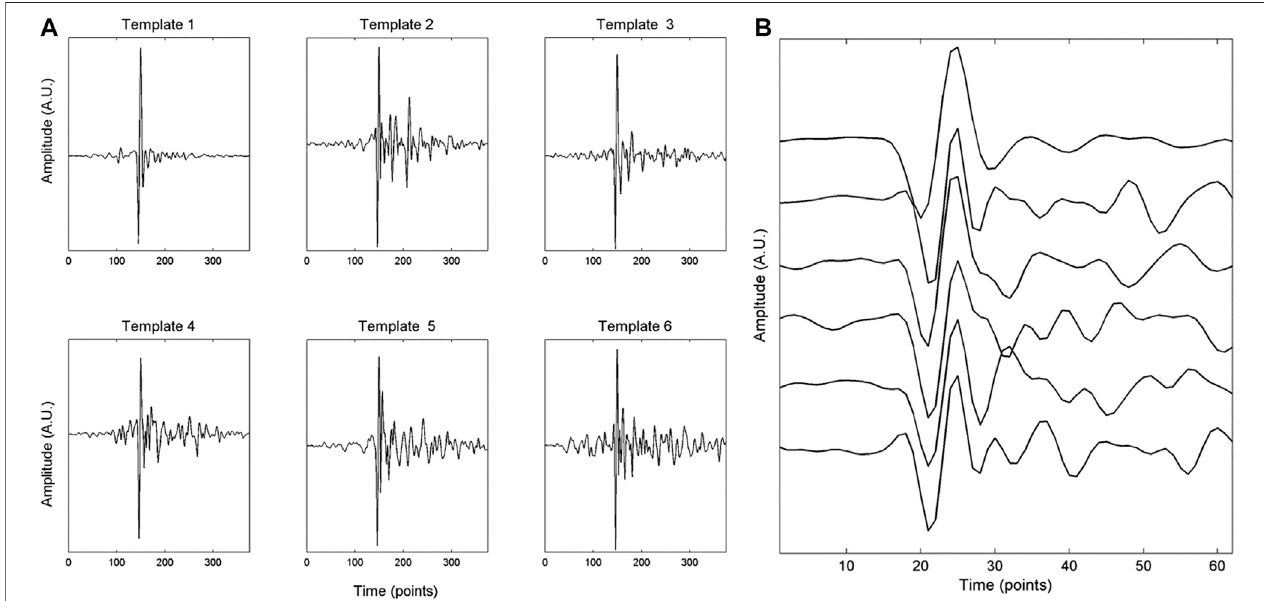
FIGURE 3 | Event waveforms composing the template matrix before (A) and after (B) pre-processing.